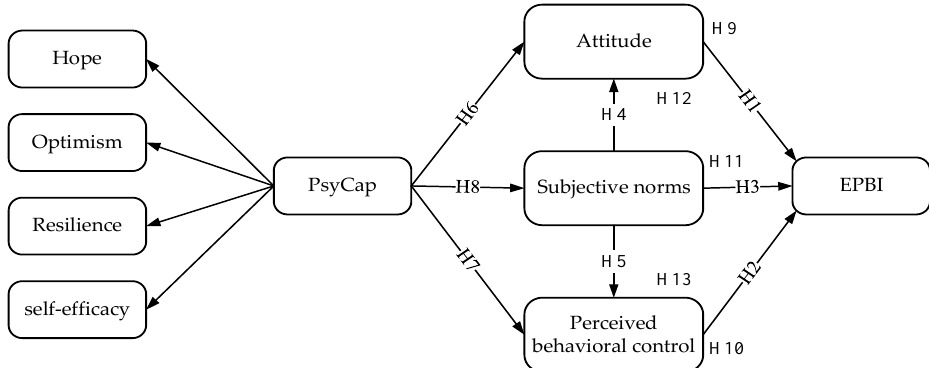
Figure 1. The model of influencing factors of MHO staff’s EPBI.